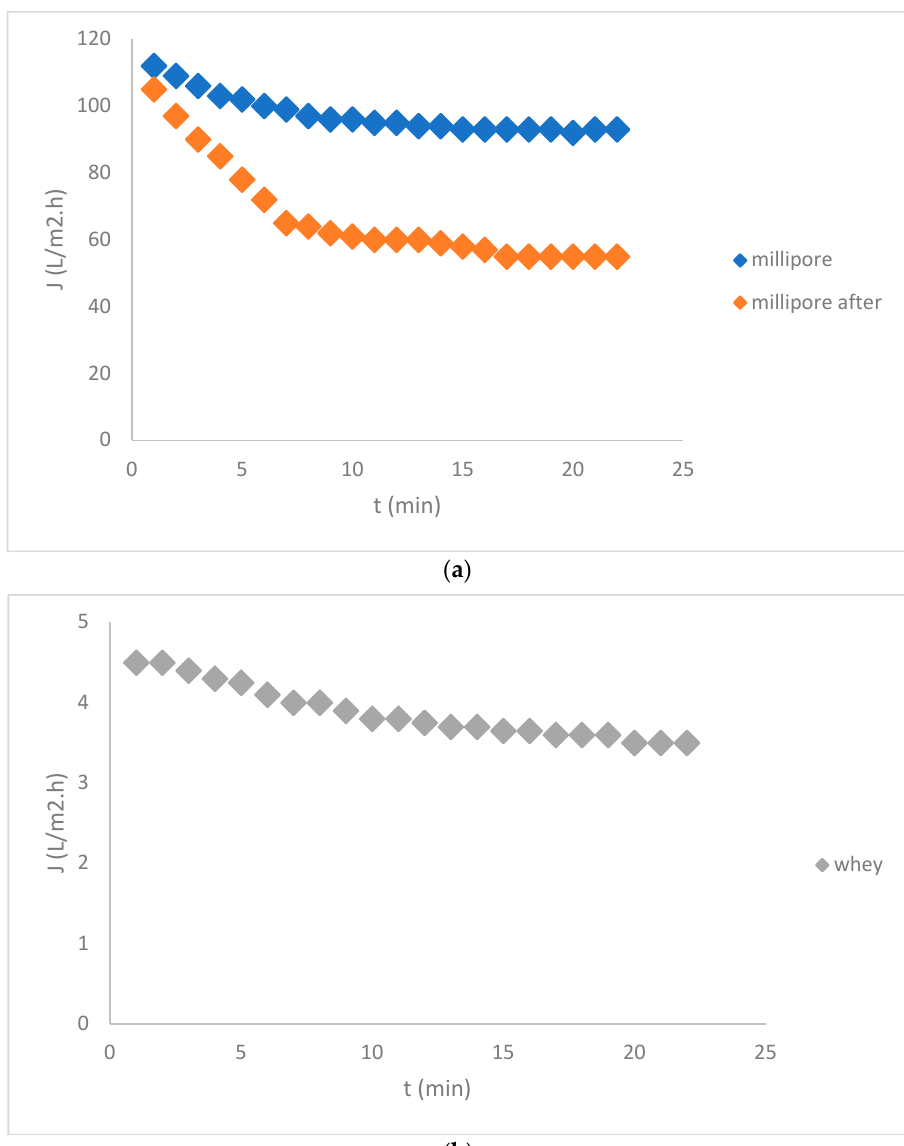
Figure 3. Flux dependent on TMP for the ceramic membrane at filtering whey.